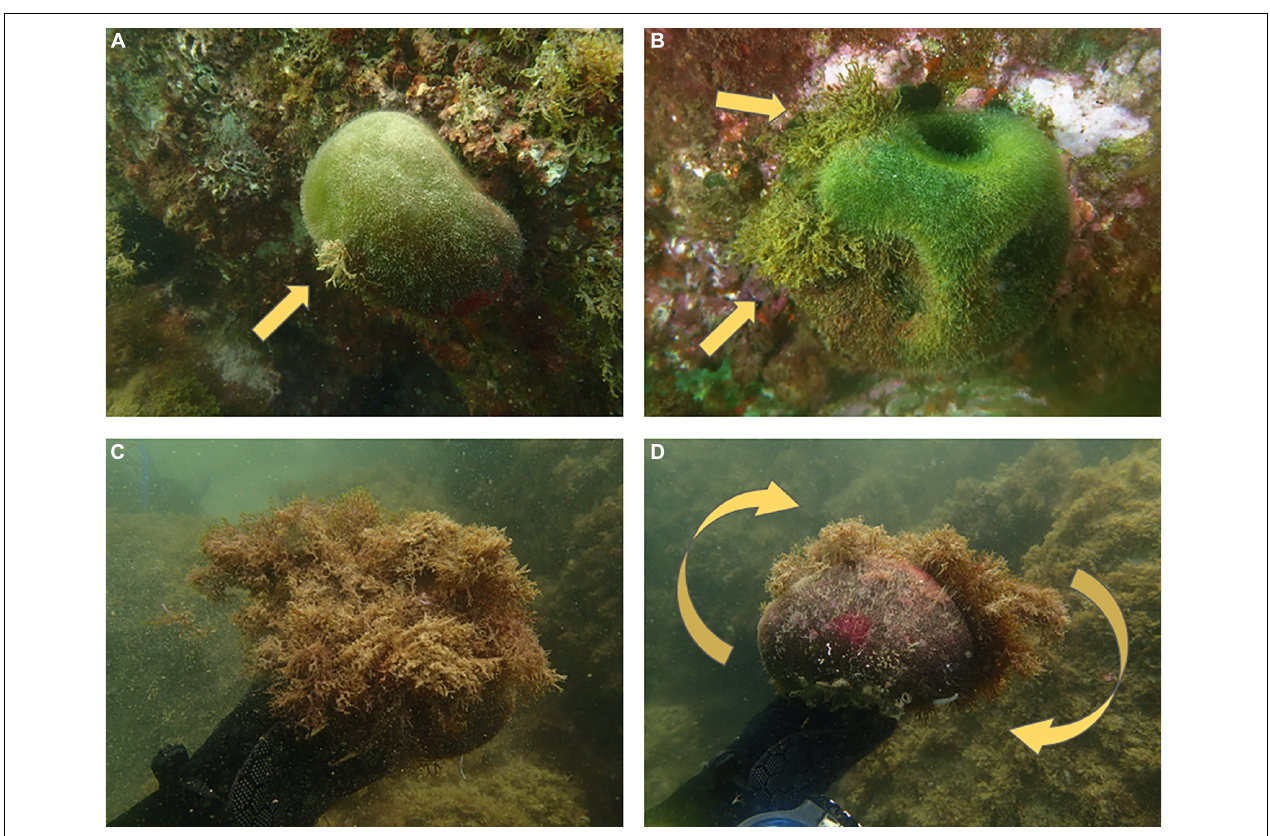
FIGURE 6 | Example of progressive epibiosis of Codium bursa by Rugulopteryx okamurae . (A) Incipient occurrence after R. okamurae establishment. (B) Progress of R. okamurae spatial growth. (C) C. bursa extremely epiphyted by R. okamurae . (D) Opposite side of the same individual of C. bursa showing depigmented tissue in lateral and basal